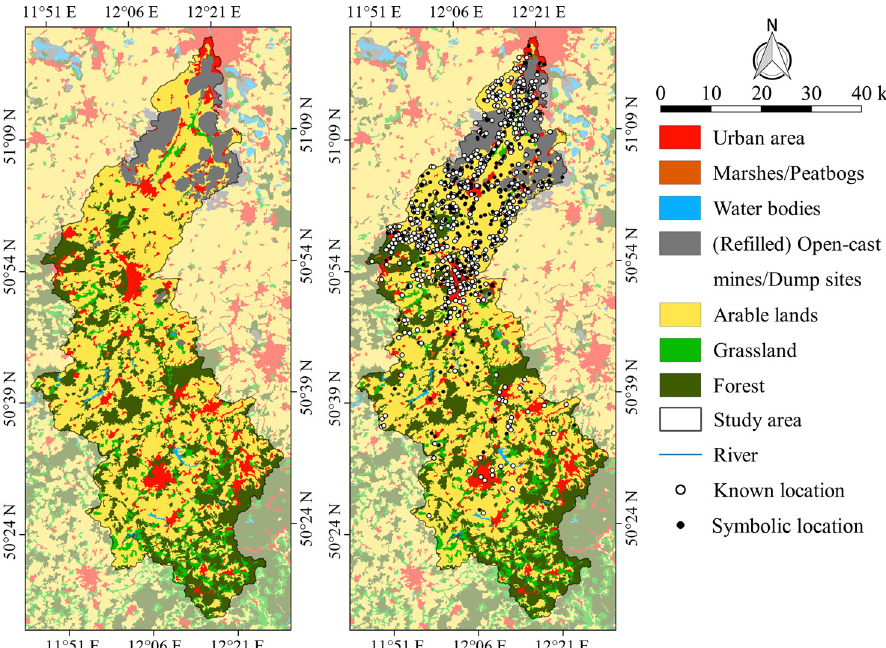
Fig 7. Modern land use and Neolithic site distribution in the study area. Distribution of modern land use classes according to CORINE Land Cover data [83]. The spatial extent of the (refilled) open-cast mines has been modified according to older topographic maps (S2 Table; S2 Fig).